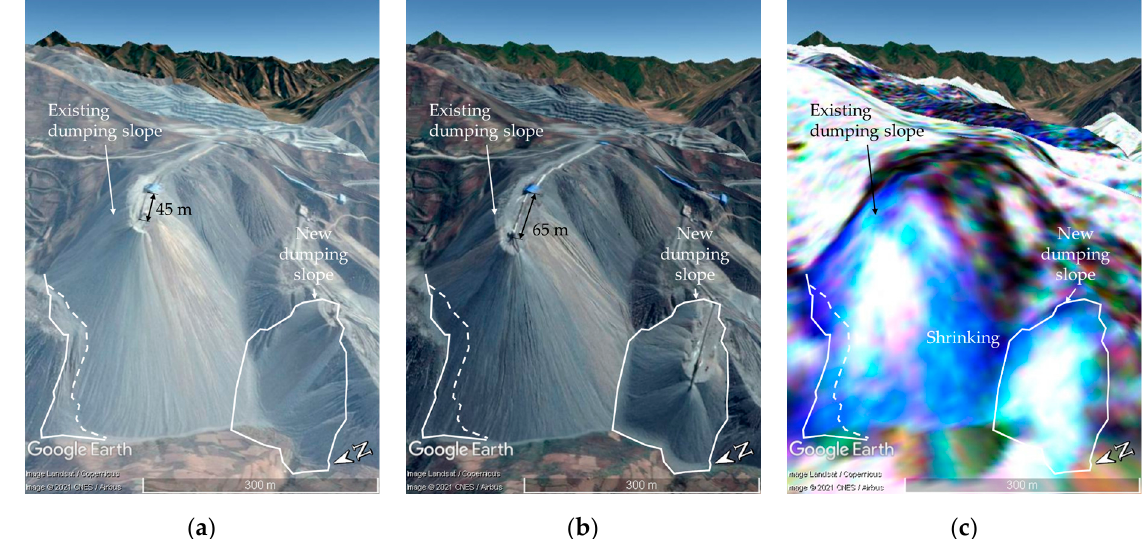
Figure 16. West Dumping Site 3 (WD3). ( a , b ) are Google Earth images taken on 7 October 2015 and 26 September 2019, respectively. ( c ) is the RGB composite of the annually averaged NDAI map (R: 2019, G: 2018, and B: 2017). Dashed lines are drawn based on the 2015 Google Earth image, while solid lines are on 2019.